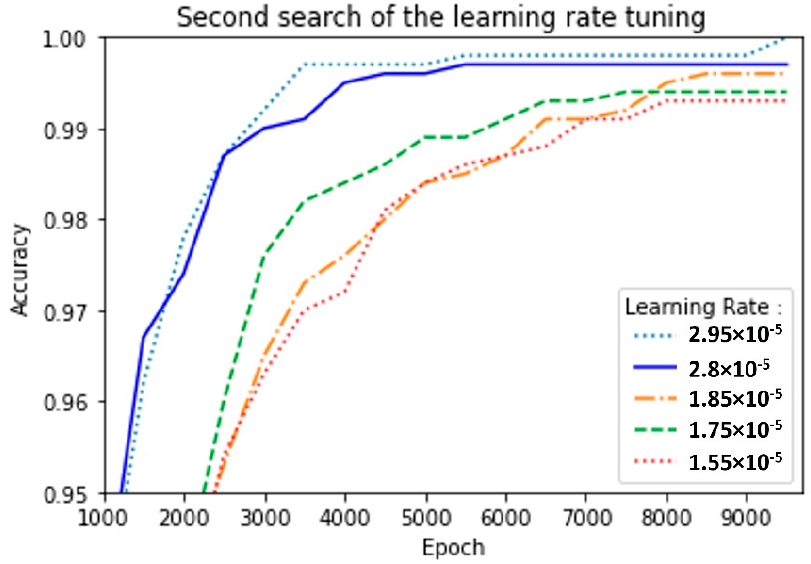
Figure 9. Accuracy score for training dataset with MLP model during first learning rate search.